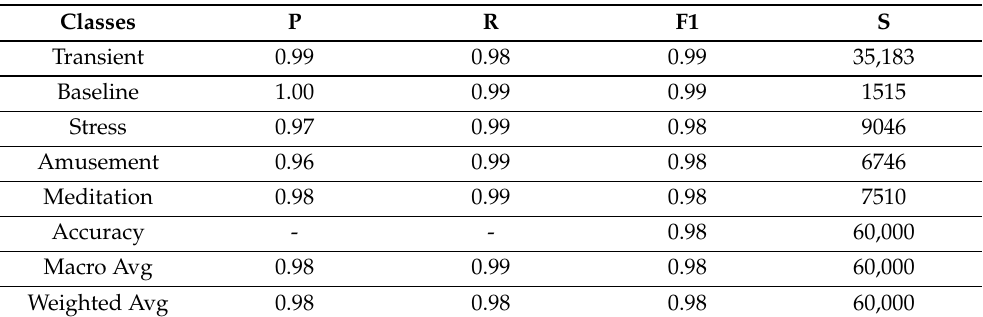
Table 6. Proposed model result of Client 2 for round 3. Key: Precision-P; Recall-R; F1-score-F1;